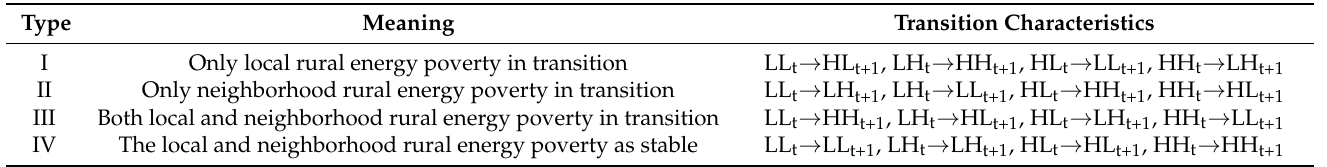
Table 2. Spatiotemporal transition type of rural energy